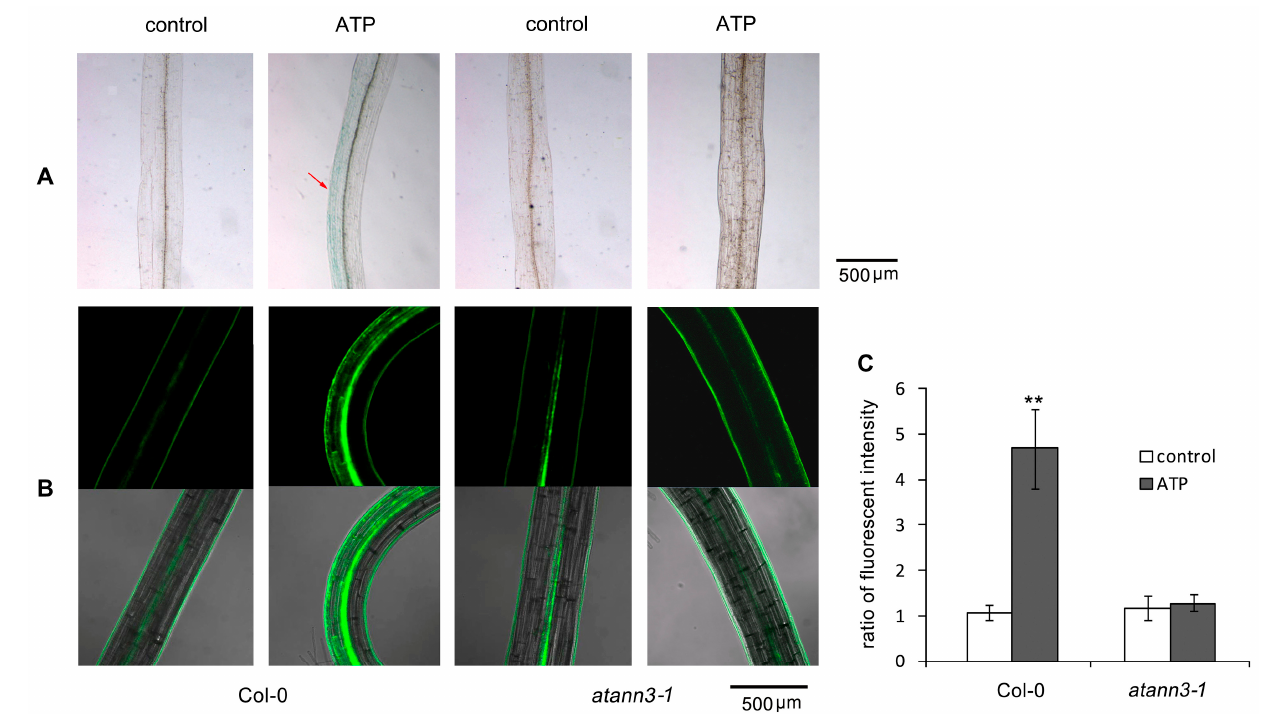
Figure 3. AtANN3 is involved in the eATP-induced DR5-GUS or DR5-GFP distribution in the etiolated hypocotyl cells. The 4-day-old etiolated seedlings of DR5-GUS or DR5-GFP transgenic lines were transplanted onto the medium containing 0.5 mM ATP and cultured for 2 more days. ( A ) The DR5-GUS expression in representative hypocotyls. The red arrow indicates the accumulation area of DR5-GUS. ( B ) The DR5-GFP fluorescence in representative hypocotyls. The scale bar is shown in the lower-right corner of each figure. ( C ) The fluorescence intensity ratio (FIR) in cells at the inner side/outer side at the hypocotyl curve. In this experiment, at least 15 samples were measured, and data from at least three replicates were combined to obtain mean ± SD based on Student’s t -test p -values (** p < 0.01).